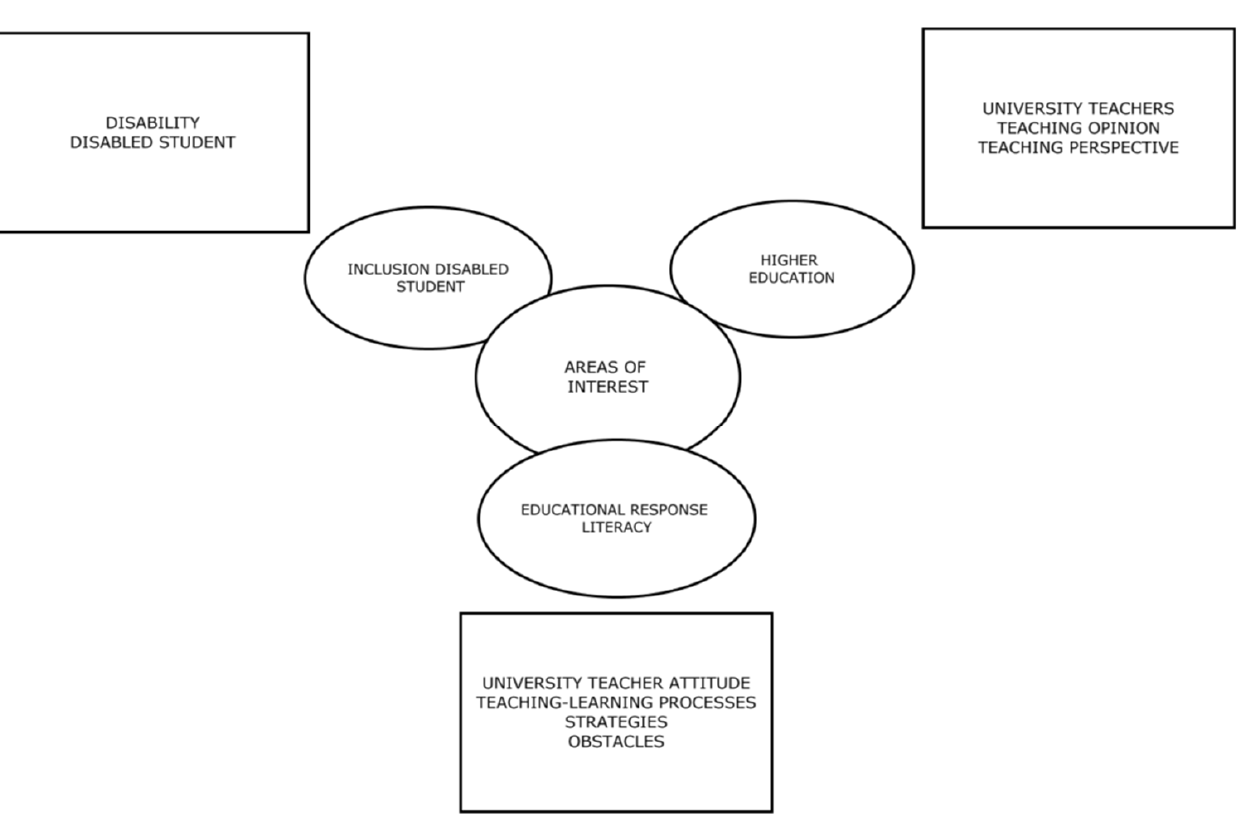
Figure 1. Diagram of search terms used in the systematic review.